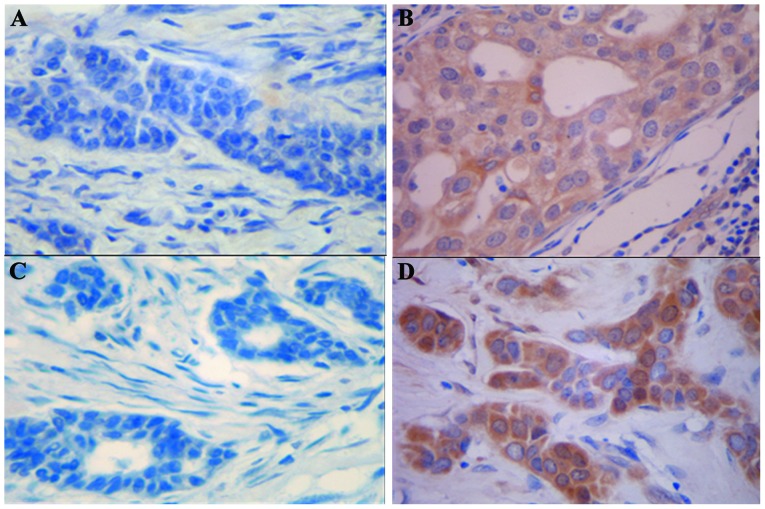
Immunohistochemical analysis, demonstrating (A) negative and (B) positive phosphorylated Akt staining; and (C) negative and (D) positive phosphorylated extracellular-regulated kinase 1/2 staining in moderately-differentiated carcinoma (magnification, ×400).